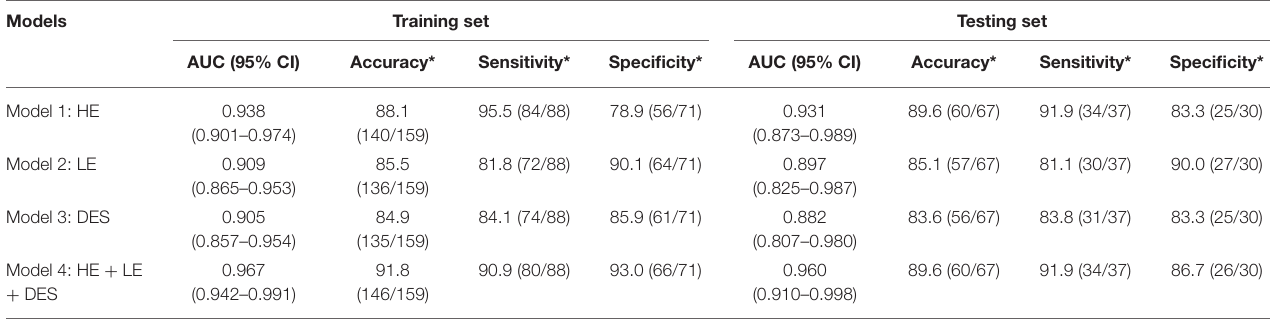
TABLE 2 | The performances of the best classification